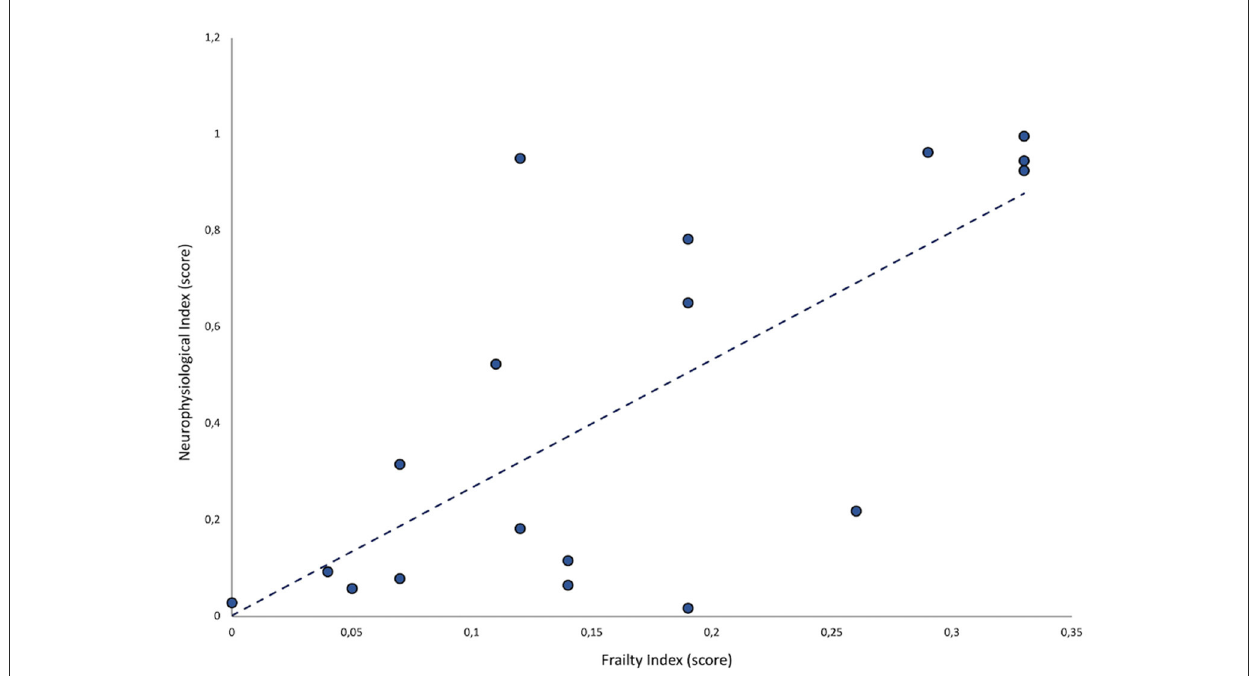
FIGURE1 Correlation between neurophysiological index (NI) score and frailty index (FI)